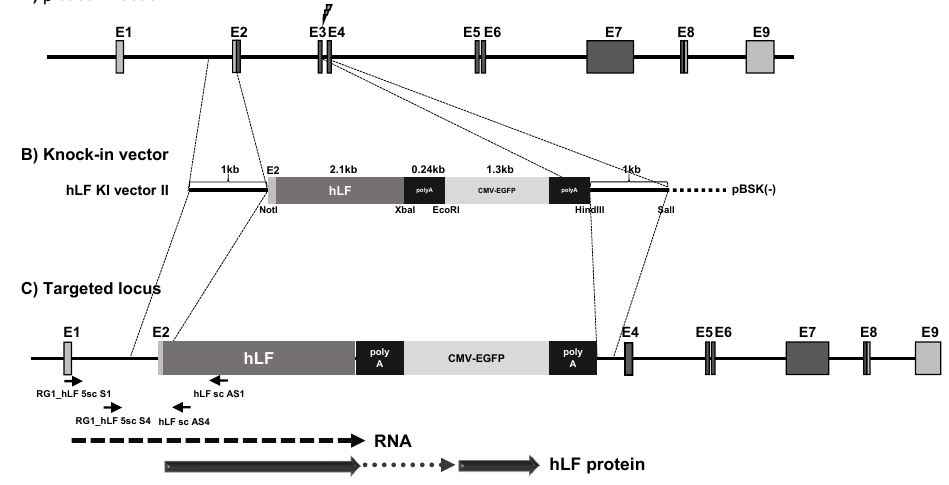
Figure 1. The knock-in strategy targeting the bovine β-casein gene locus. The diagram shows the targeting strategy of knock-in vectors by HR in the β-casein gene locus. (A) Genome structure of the β-casein gene locus. (B) hLF knock-in vector II. (C) Targeted structure of knock-in vector by HR. The hLF transgene is expressed by β-casein gene regulatory DNA sequence and mRNA is translated with β-casein by ribosome. The hLF pro - tein is synthesized and secreted using the β-casein gene locus. The polymerase chain reaction primer pairs used for detecting HR events are indi - cated by arrows. HR, homologous recombination; hLF, human lactoferrin.